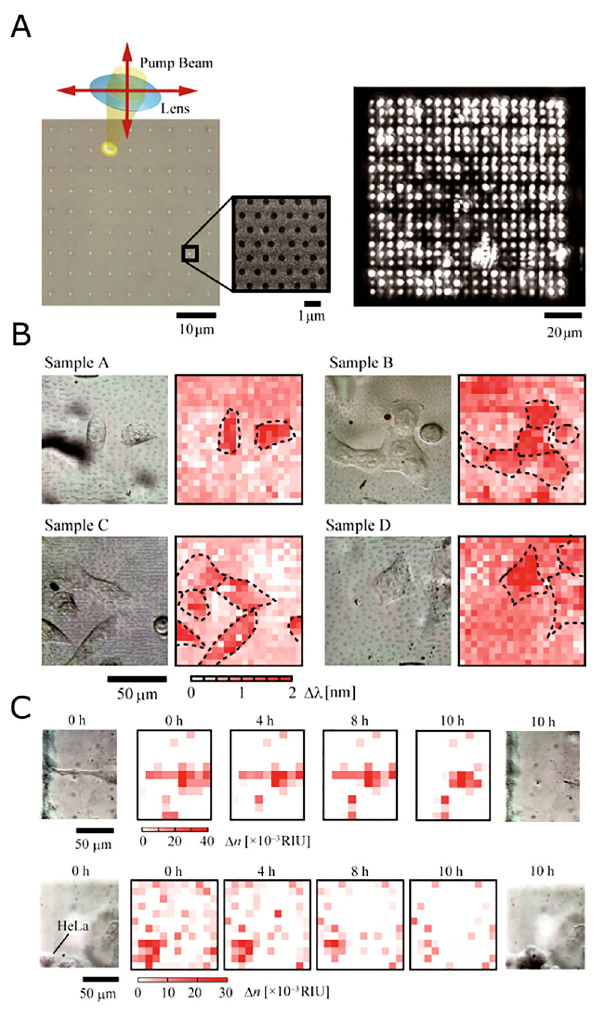
Figure 6: Imaging living cells. (A) SEM image of uncoupled nanolaser array (left) and near-field emission of the array (right). (B) Δ λ image (right panels) of different samples of cells (optical micrographs; left panels) and (C) Δ n image (center panels) tracking movement of a single cell (optical micrographs; left and right panels). Reprinted from a study by Abe et al. [59] with